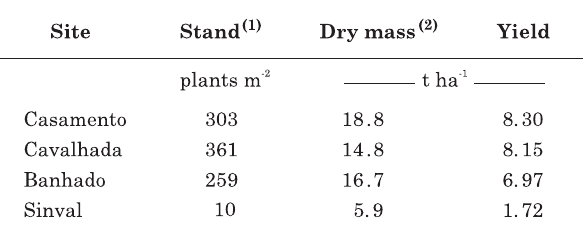
(1) At V4 growth stage (Counce et al., 2000). (2) At full